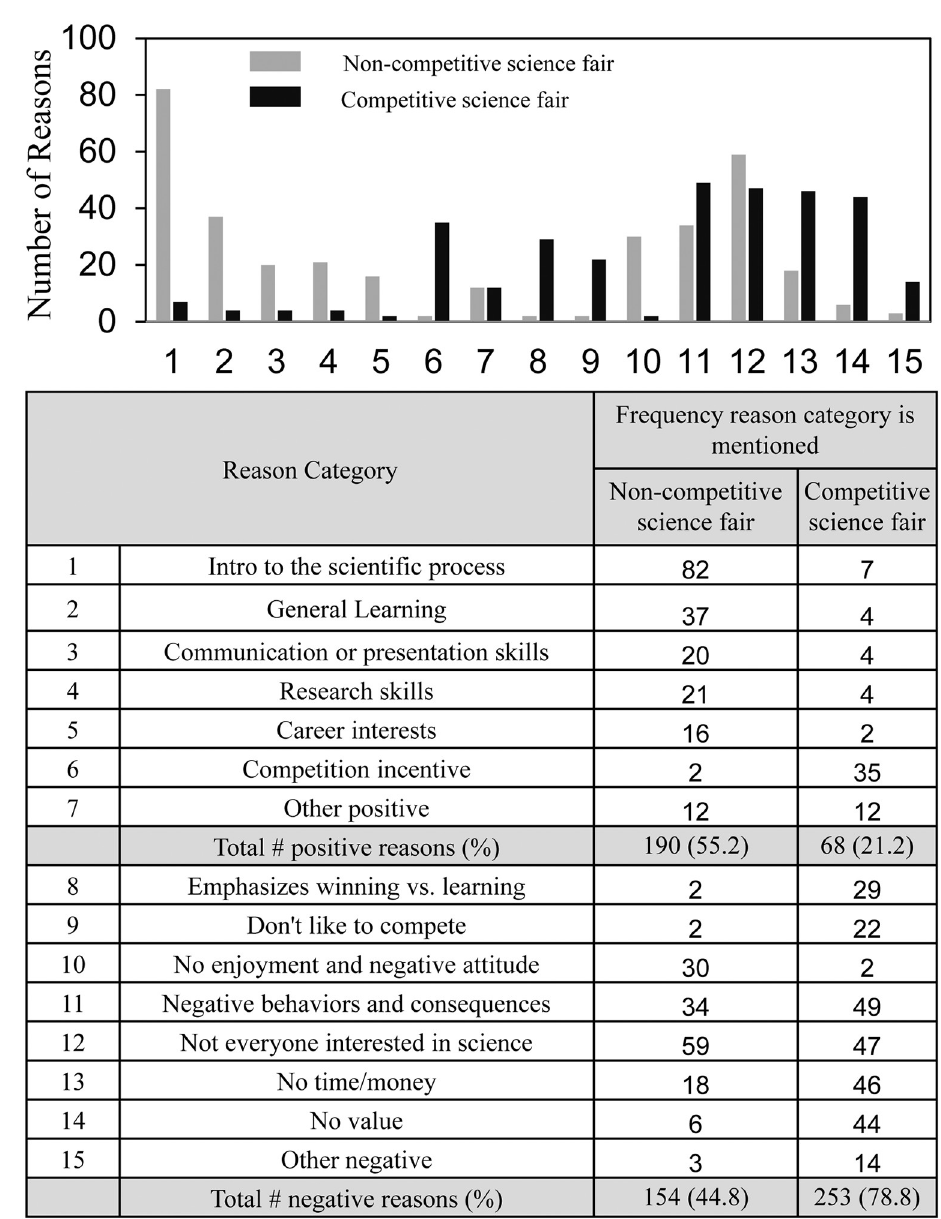
Fig 3. Students’ reasons why science fair should be optional or